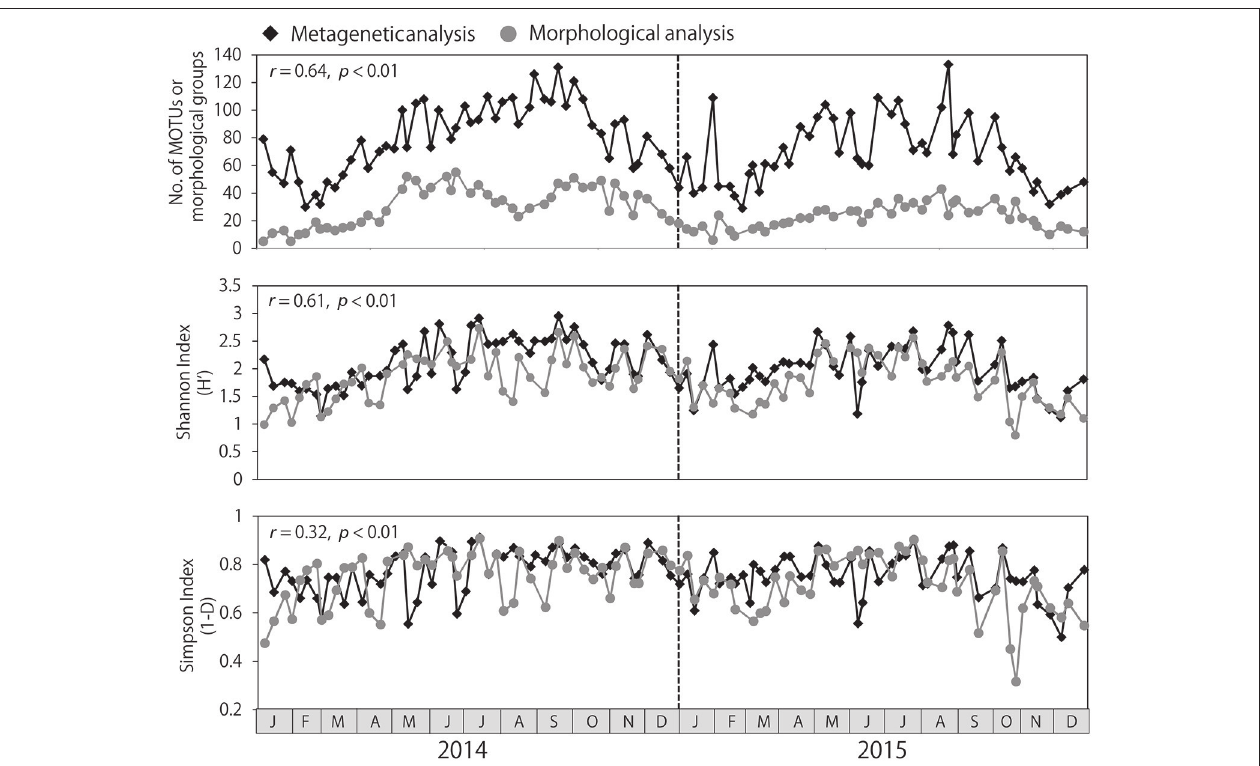
FIGURE 3 | Seasonal changes in zooplankton diversity detected by metagenetic and morphological analyses, including numbers of both molecular taxonomic units (MOTUs) and morphological groups. Shannon and Simpson diversity indexes were calculated based on sequence read numbers in the metagenetic analysis and based on abundance (individuals/m 3 ) in the morphological analysis. Correlations between metagenetic and morphological analyses are represented using Pearson’s product-moment correlation coefficients ( r